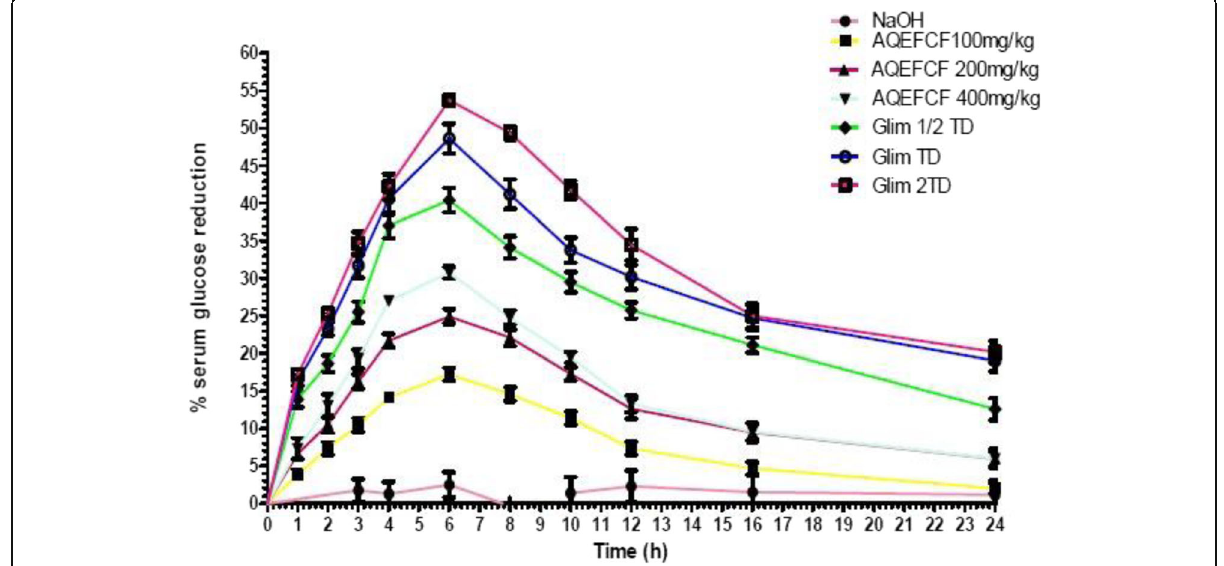
Fig. 3 Effect of repeated dose of C.frutescens and glimepiride on serum glucose level in diabetic